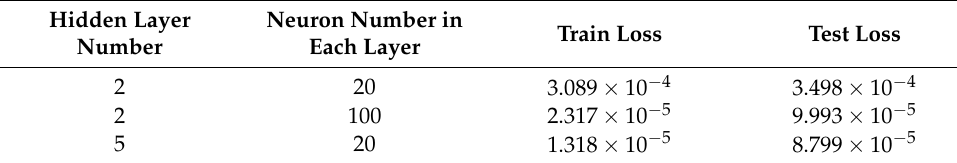
Table 8. Train and test loss of neural